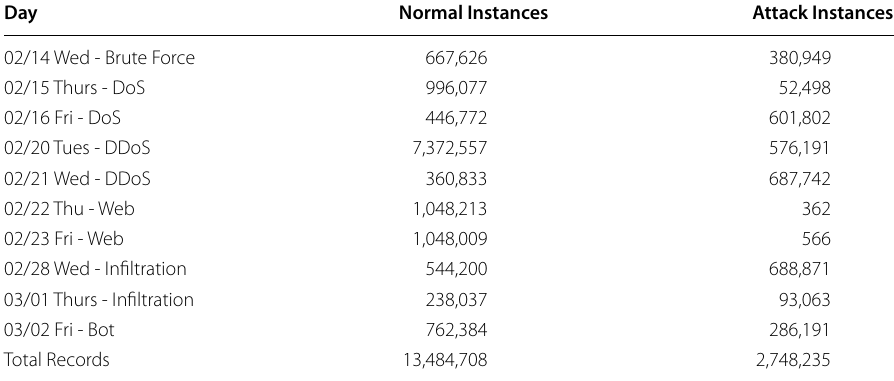
Table 1 Entire CSE-CIC-IDS2018 Dataset by files/days (only web attacks and normal traffic are used in our experiments) Day